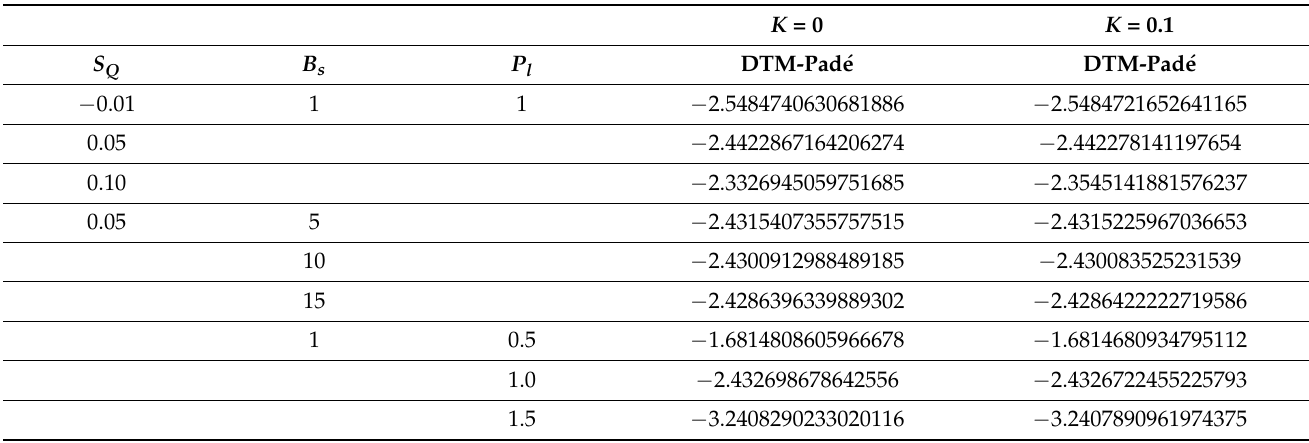
Table 4. Analysis of χ (cid:48) ( 0 ) for various values of S Q , B s , P l by DTM-Pad é [ 5 × 5 ] .